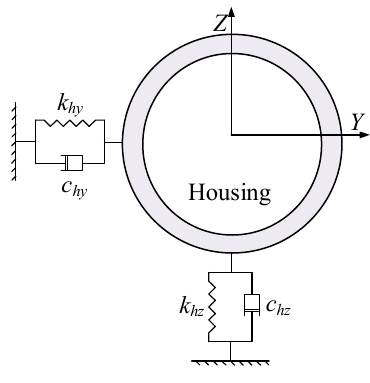
Figure 3. The housing model.